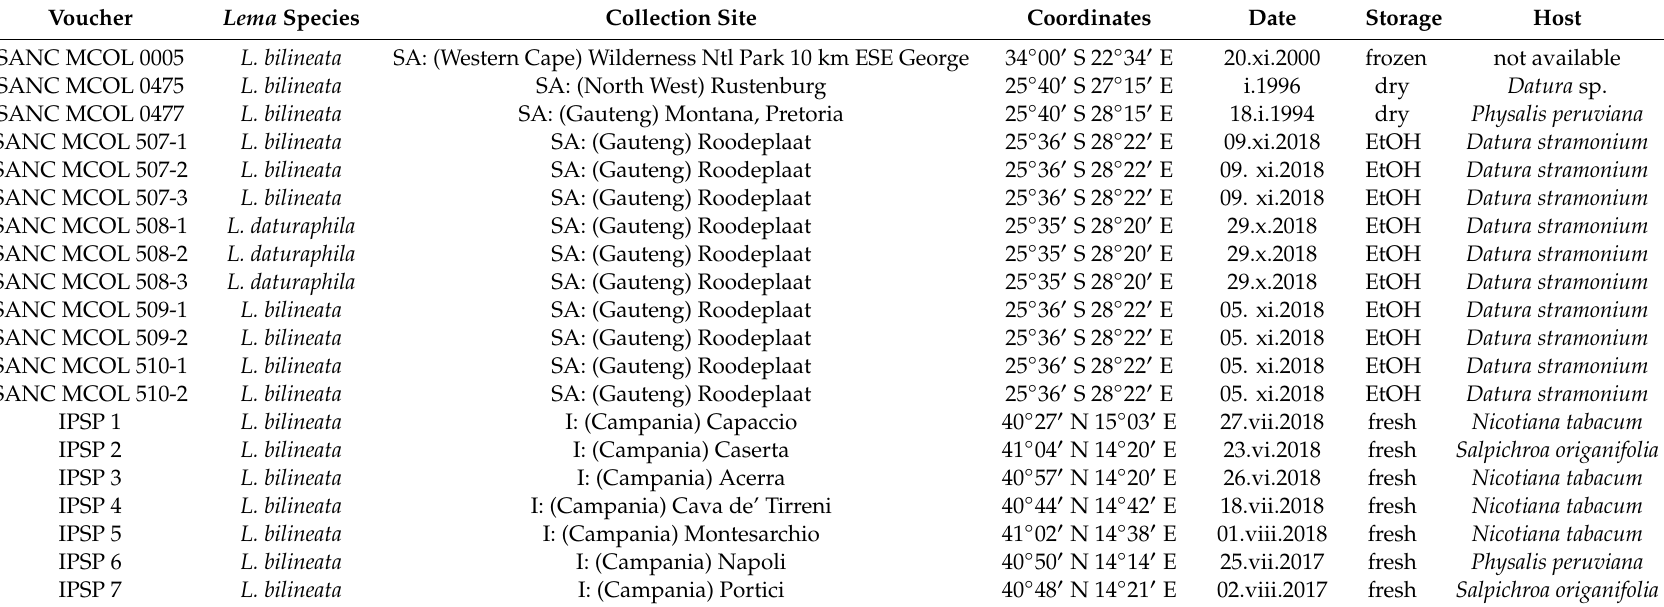
Table 1. List of novel sequenced specimens of Lema bilineata and L. daturaphila . SA: South Africa, I: